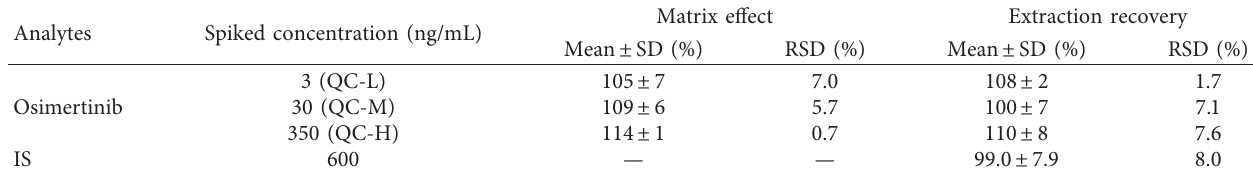
Table 4: Matrix effect and extraction recovery of osimertinib in rat plasma ( n � 6). Analytes